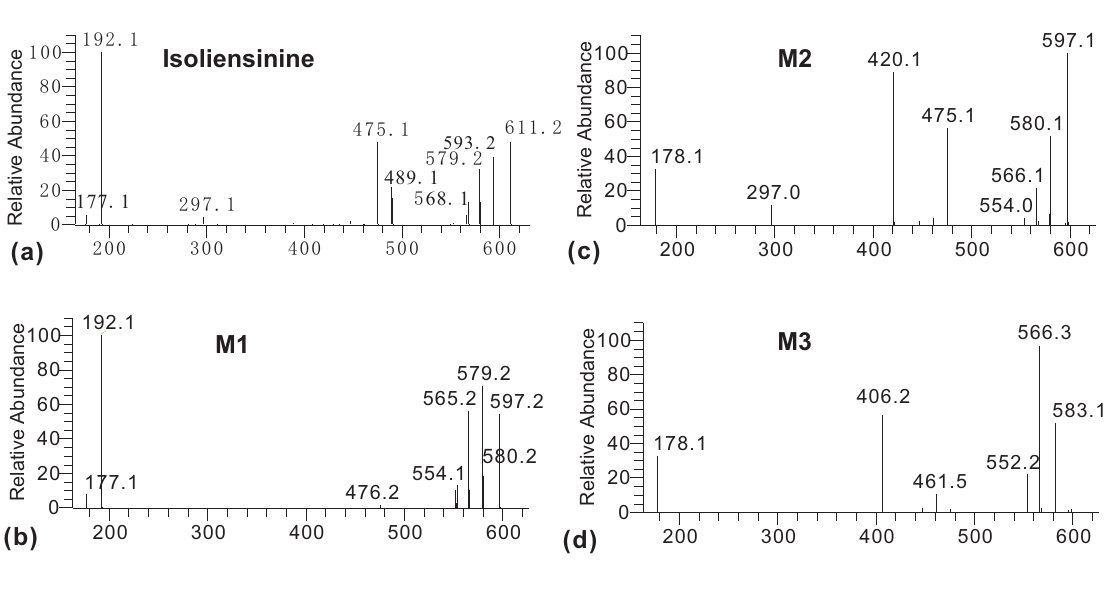
Figure 3. Positive ESI-MS/MS spectra of ( a ) standard isoliensinine and ( b – d ) microsomal metabolites M1 – 3 .